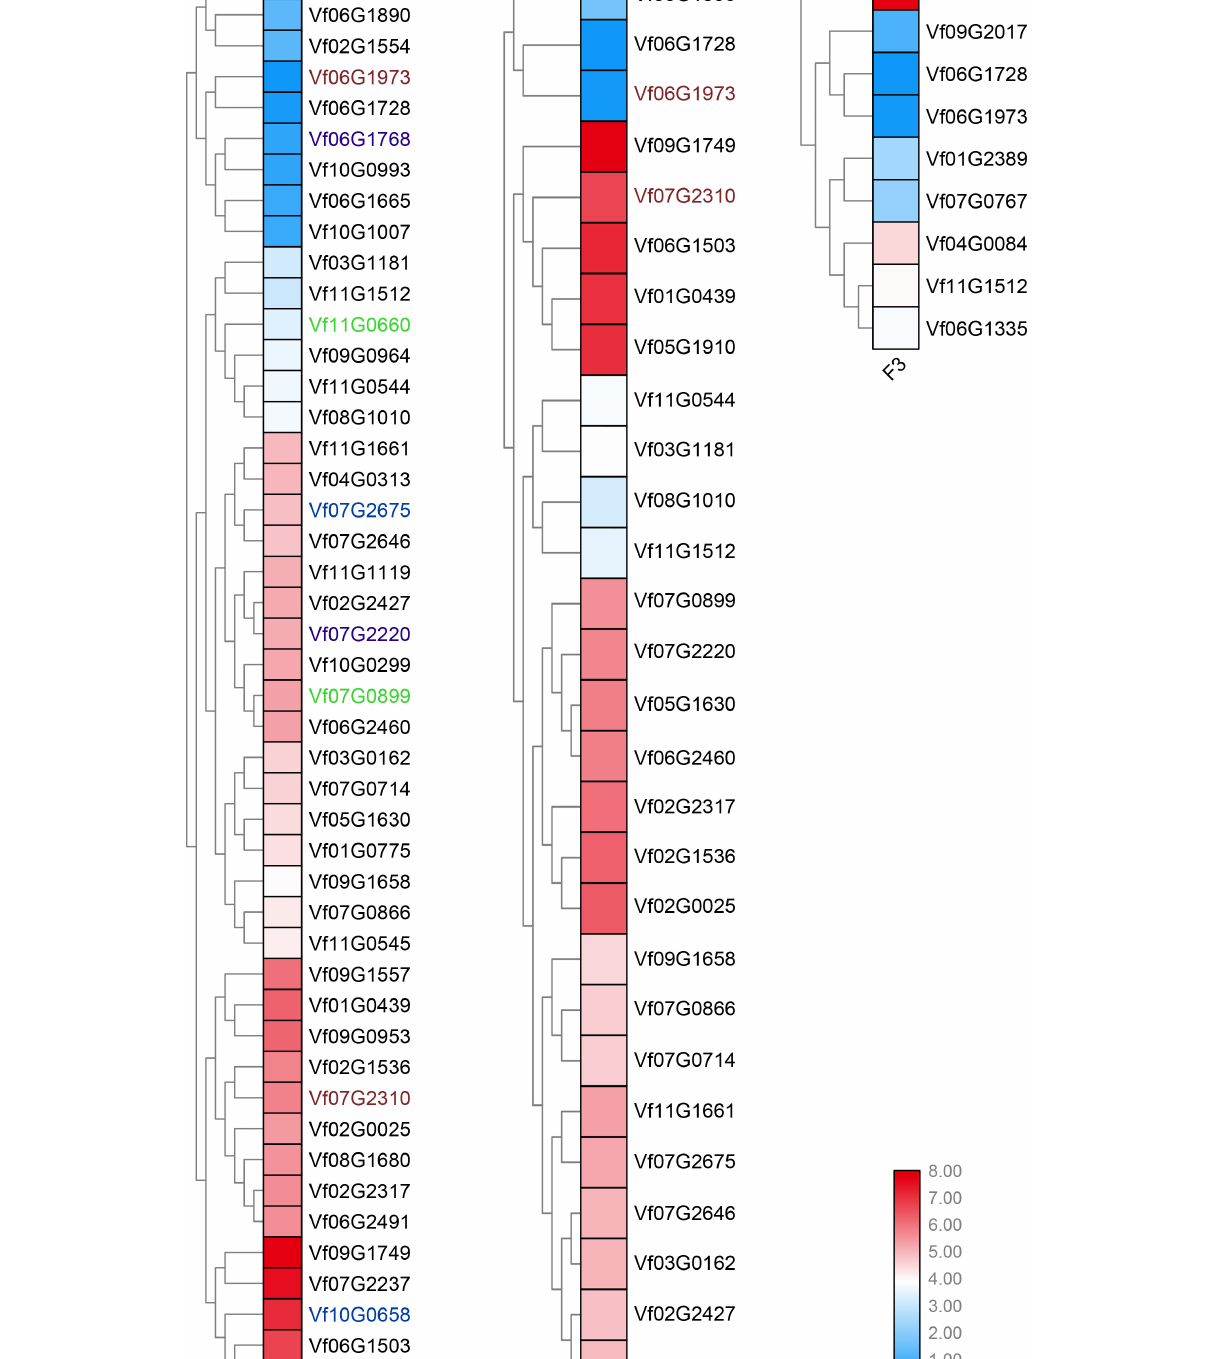
Frontiers in Plant Science |